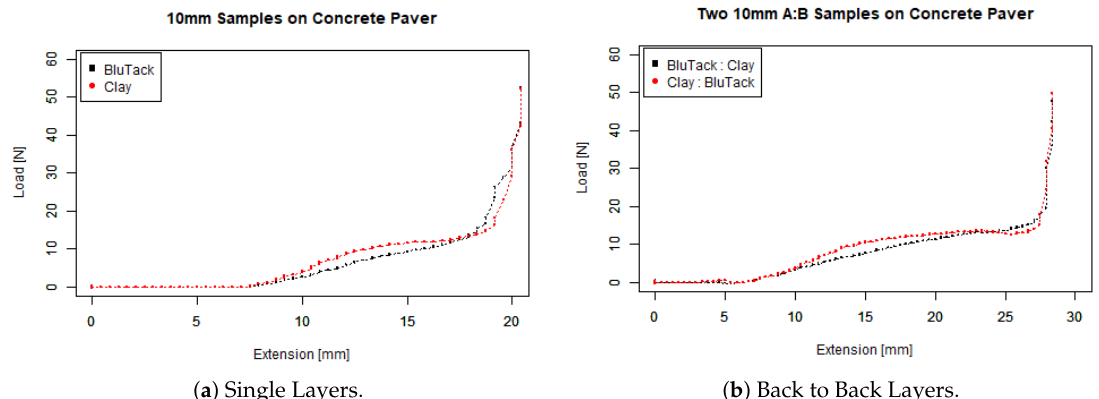
( a ) Single Layers. ( b ) Back to Back Layers. Figure 12. Penetrometer testing soft layers on